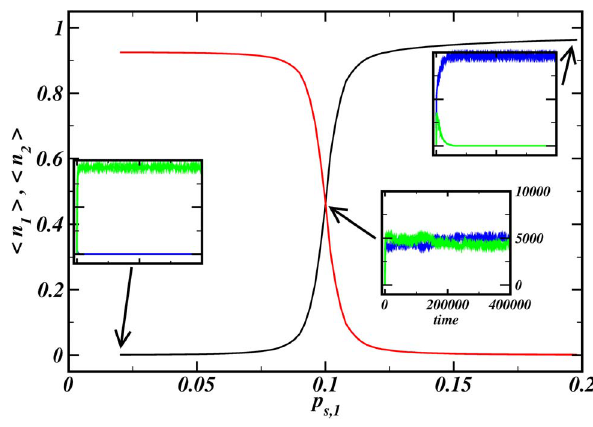
Figure 7. Switch-like behavior for competing histone marks. We take the temporal average of the number of with mark m modified histones after the simulation reached a stationary-like state, v n m w , presenting now the average frequency of a histone mark. A clear transition between two saturated states is observed, where the number of modifications fluctuates maximally for p s ,1 & 0 : 1 . Inner panels: evolution of the number of modifications for different parameter sets. The other parameters were N N ~ 100 , p s ,2 ~ 0 : 1 , p d ~ p a ~ 0 : 01 .